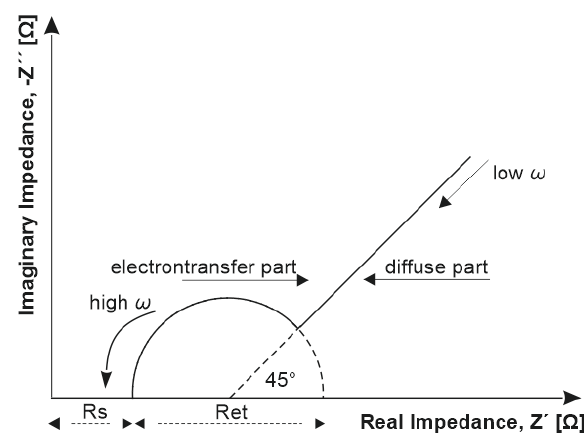
Figure 4: A typical Nyquist plot made from EIS investigation to obtain key EIS